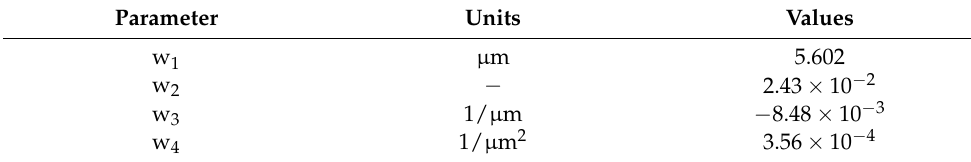
Table 6. Coefficients of Equation (24) for the CFL thickness